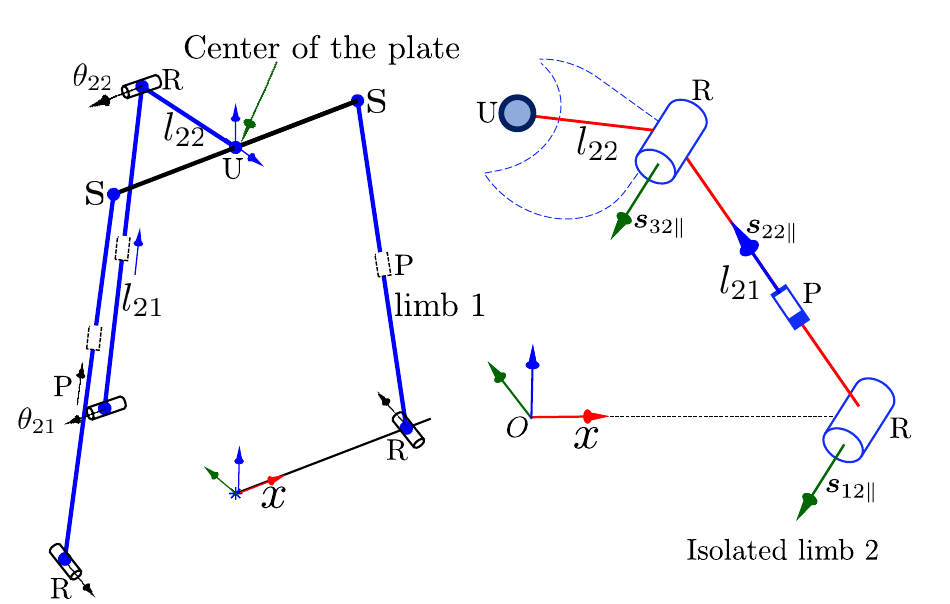
Figure 10. Non-Parasitic motion enhanced performance manipulators ( left ). Isolated limb ( right